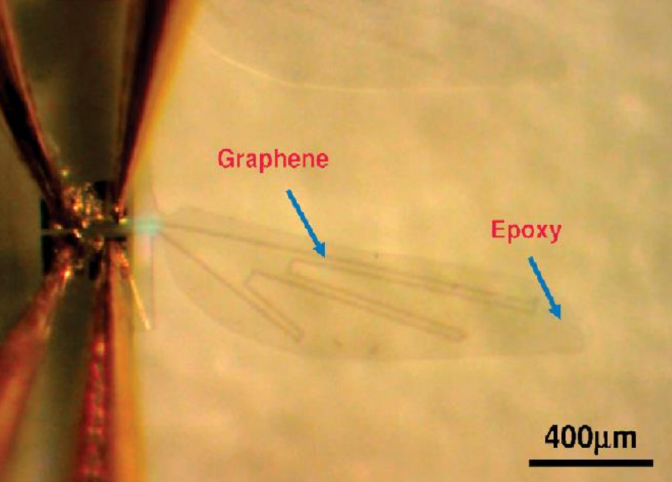
Figure 10. A Graphene on organic film in the form of a dragonfly wing. Reproduced with permission from [106].